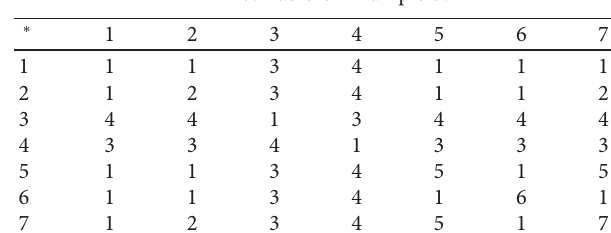
Table 5: Table of Example